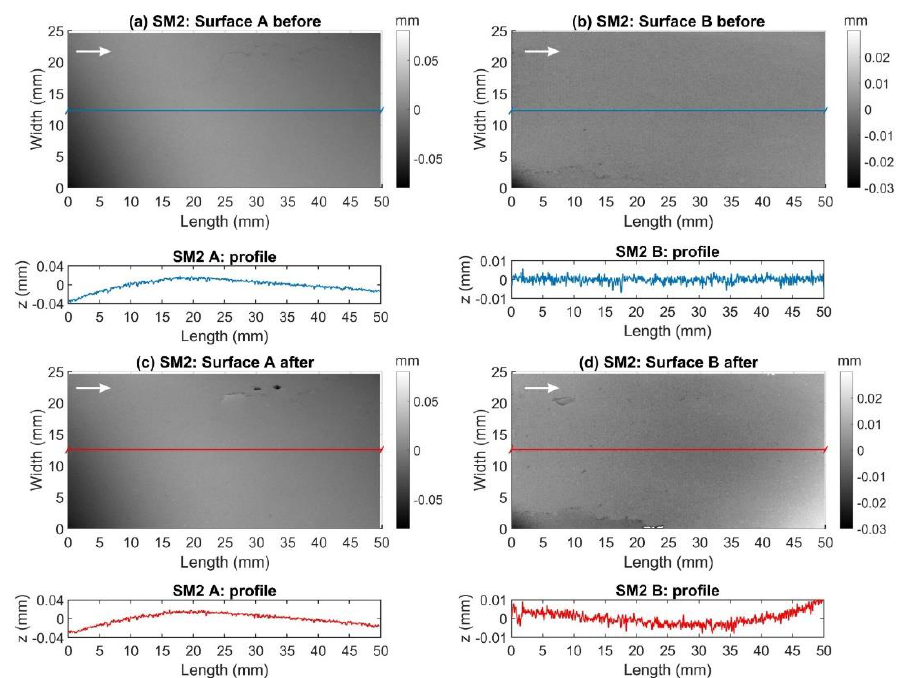
Figure A2. Fracture surface topographies and the central profiles of sample SM2 before ( a , b ) and after ( c , d ) the entire experiments, where the arrows indicate the flow direction.